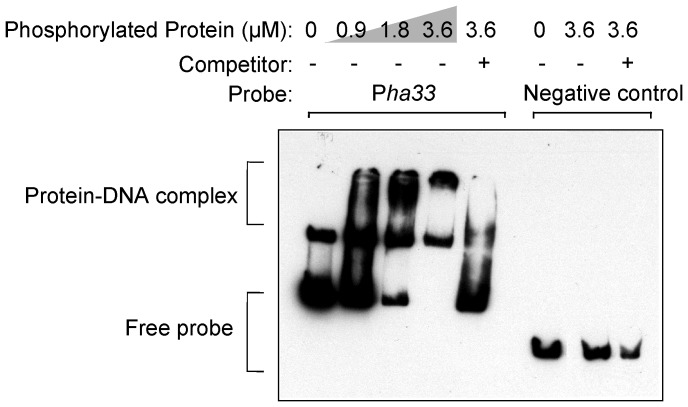

In vitro phosphorylated CBO0786 binds to Pha33 probe in vitro.EMSA showing phosphorylated CBO0786 binding to Pha33 probe. Specificity was confirmed using 200-fold molar excess of non-labeled competitor DNA and a random gene fragment as negative control.